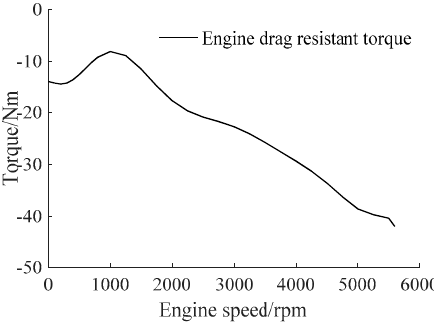
Figure 3. Engine drag resistance torque.